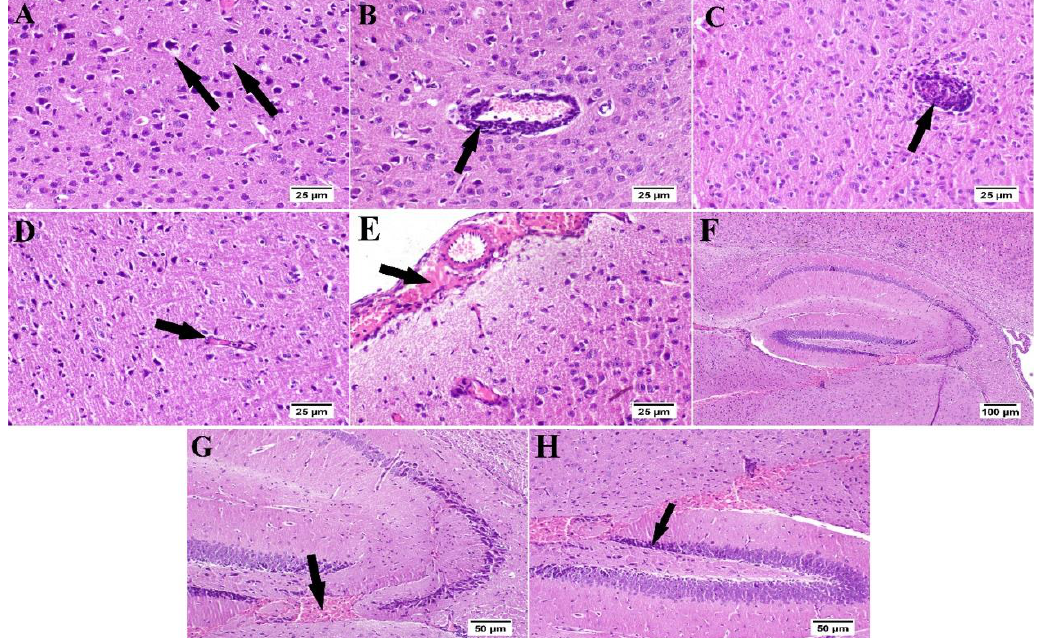
Figure 8. Histopathological alterations induced by STZ injection (n = 3) (H&E). Mice injected with STZ (group III) showed ( A ) dark degenerated neurons (arrows) of the cerebral cortex with neuronophagia and diffuse gliosis. The cerebral cortical blood vessels also exhibited ( B ) vasculitis (arrow) associated with neuronal degeneration and neuronophagia. ( C ) The striatum revealed severe vasculitis (arrow) with diffuse gliosis in addition to ( D ) congestion (arrow) and dark shrunken degenerated neurons. ( E ) The meninges showed congestion, thickening of the blood vessel wall, and perivascular hemorrhage (arrow). ( F ) The hippocampus revealed hemorrhage (arrow) with ( G ) dark shrunken degenerated neurons (arrow) in cornu ammonis (CA) 3 and 4 and ( H ) dentate gyrus (DG) regions .